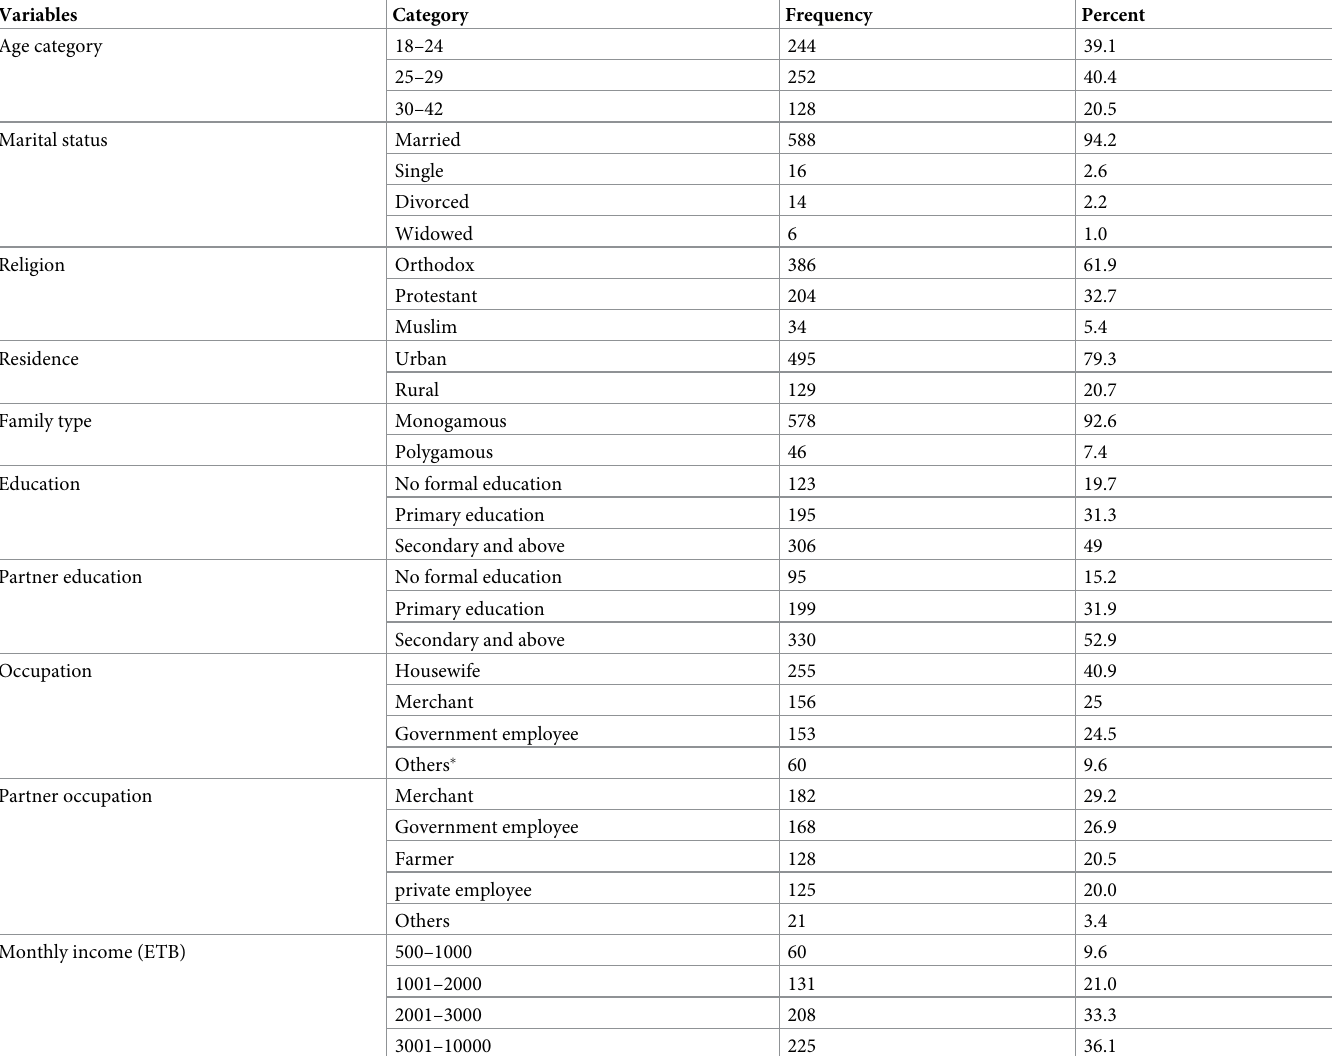
Table 1. Socio-demographic characteristics of study participants in Jinka town public health facilities, southern Ethiopia, August 21-September 9, 2020 (n =